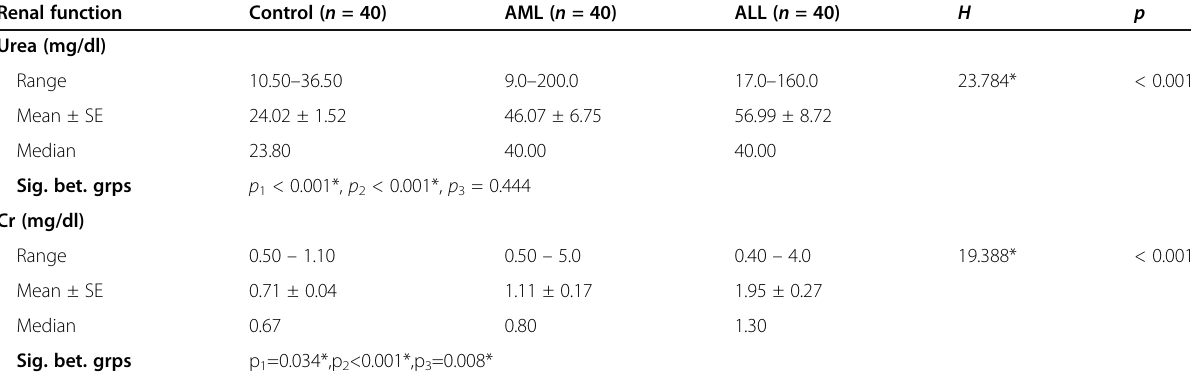
Table 4 Kidney functions in AML and ALL patients and control group Renal function Control ( n = 40) AML ( n = 40) ALL ( n = 40) H